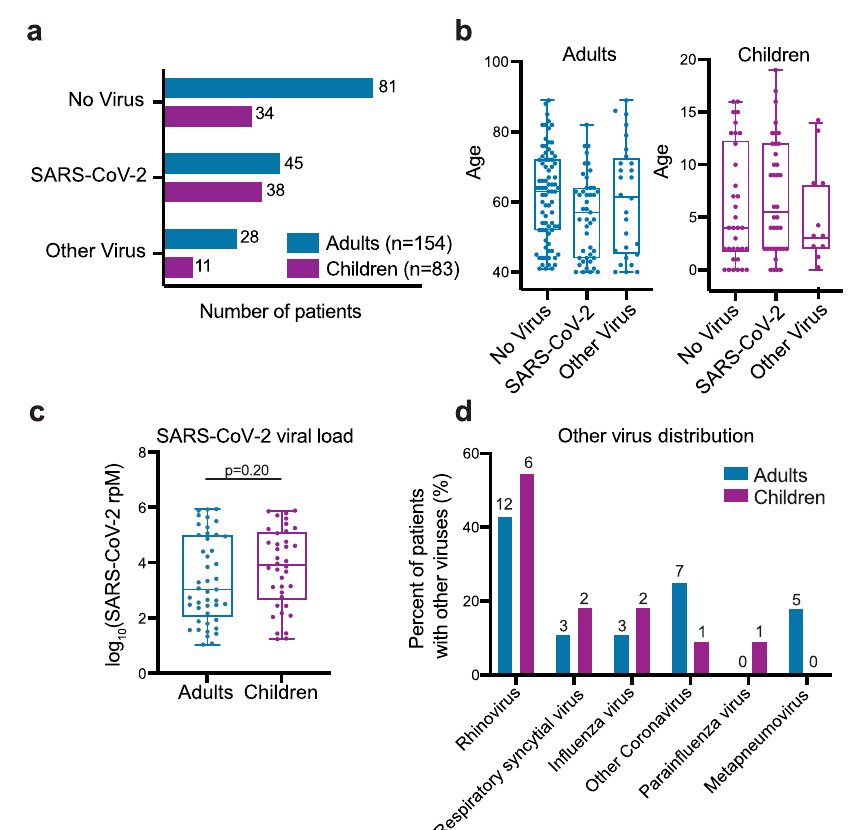
Fig. 1 Patient numbers, age distribution, SARS-CoV-2 viral load and other viruses present in the adult and pediatric cohorts. a Number of patients in the SARS-CoV-2, No Virus and Other Virus groups in the adult and pediatric cohorts. Color indicates the age cohort. b Age distribution across the three viral status groups in the adult and pediatric cohorts. Horizontal lines denote the median, box boundaries represent the interquartile range, and whiskers extend to minimum and maximum. Adults-No Virus n = 81, Adults-SARS-CoV-2 n = 45, Adults-Other Virus n = 28, Children-No Virus n = 34, Children- SARS-CoV-2 n = 38, Children-Other Virus n = 11. c Distribution of SARS-CoV-2 viral load, measured in reads-per-million (rpM), in adult ( n = 45) and pediatric ( n = 38) patients. Horizontal lines denote the median, box boundaries represent the interquartile range, and whiskers extend to minimum and maximum. P -value derives from a two-sided Mann-Whitney test. d Distribution of viruses in the Other Virus groups in the adult and pediatric cohorts. Absolute numbers are provided above each bar, the y-axis indicates percentage out of each cohort ’ s Other Virus group. One child was infected with both in fl uenza and rhinovirus and two adults were infected with both respiratory syncytial virus and